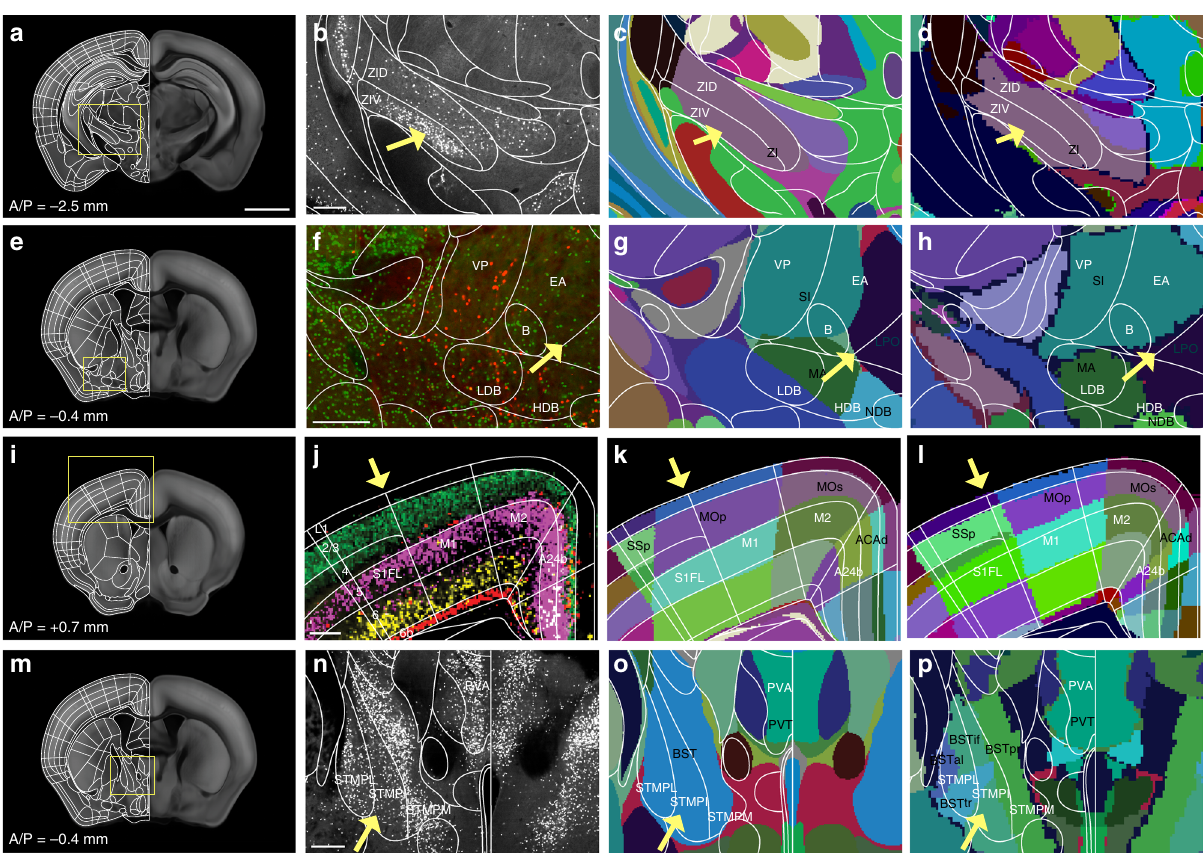
Fig. 6 Comparison between the Allen CCFv3, the ARA, and our labels. First column: Our highly segmented FP based labels on the Allen CCF. Scale bar = 2 mm, second column; our labels (white lines) with marker brain background, third column: comparison between our labels and the CCFv3 labels (colored background), fourth column: comparisons between our labels and the ARA labels (colored background). b – p Anatomical names in black and white are from the Allen CCF and our labels, respectively. b – d PV-Cre:H2B-GFP ( b ) to identify subregions in the zona incerta (ZI). Scale bar = 300 µ m. Low in dorsal and high in ventral parts (ZID and ZIV, respectively) in our labels while the CCFv3 and the ARA labels have a single combined structure for ZI. f – h ( f ) Virtual overlay of Chat-Cre:Ai75 (red) and SST-Cre:H2B-GFP (green) to compare basal forebrain regions. Scale bar = 300 µ m. g , h Our labels further segregate the single structure de fi ned as the substantia innominate (SI, Allen) into the ventral pallidum (VP) and the extended amygdala (EA). Yellow arrow highlights the border between the basal forebrain and the hypothalamus. j – l Disagreeing borders between the somatosensory and the motor cortices. Yellow arrow highlights border between the somatosensory and motor cortices. j Virtual overlay of pseudo colored Cux2:Ai75 (L2/3, green), Rbp4:Ai75 (L5, magenta), Ntsr1:Ai75 (L6, yellow), and Ctgf:Ai75 (L6b, red). Scale bar = 200 µ m. Note the lack of Cux2:Ai75 and Rbp4:Ai75 signal in layer 4 of the somatosensory cortex. n – p The BST is divided into several subregions in our labels compared to a single BST structure in the CCFv3 labels, despite the original ARA version with fi ner delineations for this structure. n SST-Cre:H2B-GFP used to identify subdivisions of BST. Scale bar = 300 µ m. Note the higher degree of segmentations in our labels compared to the CCFv3 and the ARA ( a – d , e – h, m – p ), and inconsistencies in anatomical delineations of the same structures between the atlases ( i – l ). See Supplementary Data 2 for